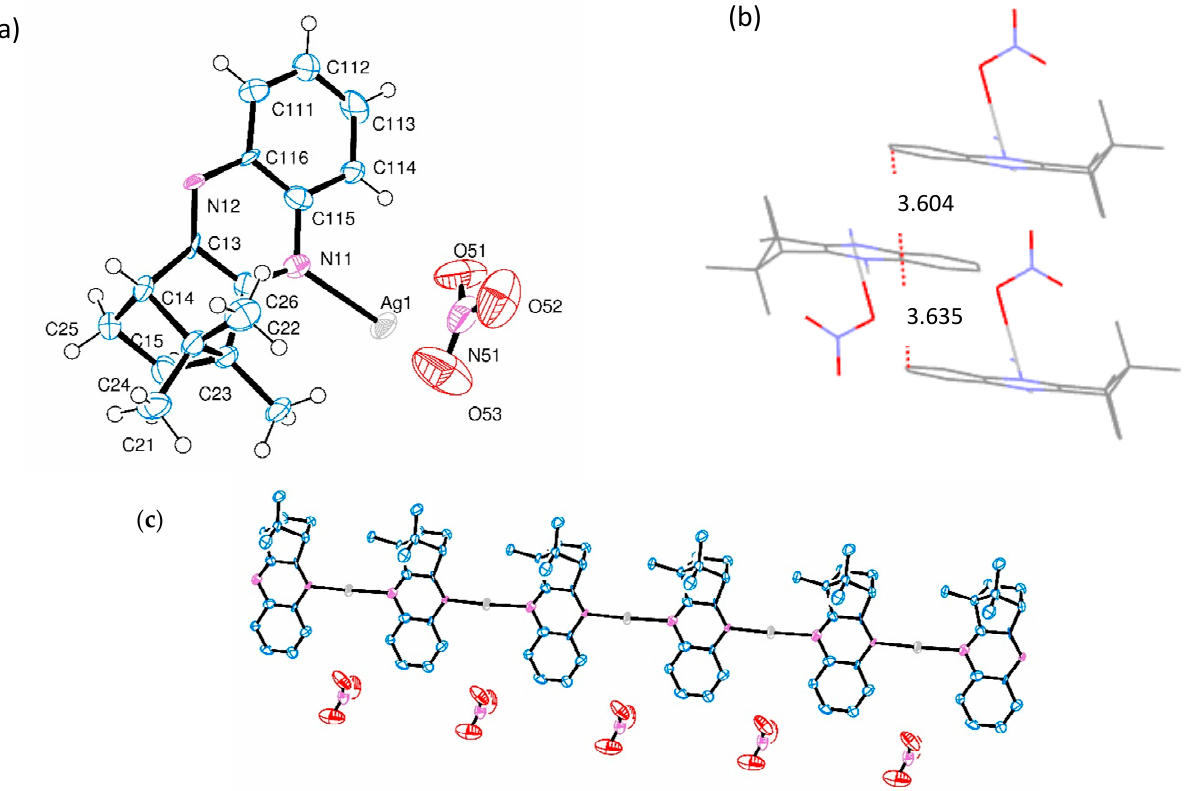
Figure 2. ( a ) ORTEP drawing for [Ag(NC 10 H 14 NC 6 H 4 )]NO 3 ( 6a ) showing labelling scheme. ( b ) Sequential layers showing distances between parallel phenyl rings. ( c ) Polymeric arrangement of 6a .